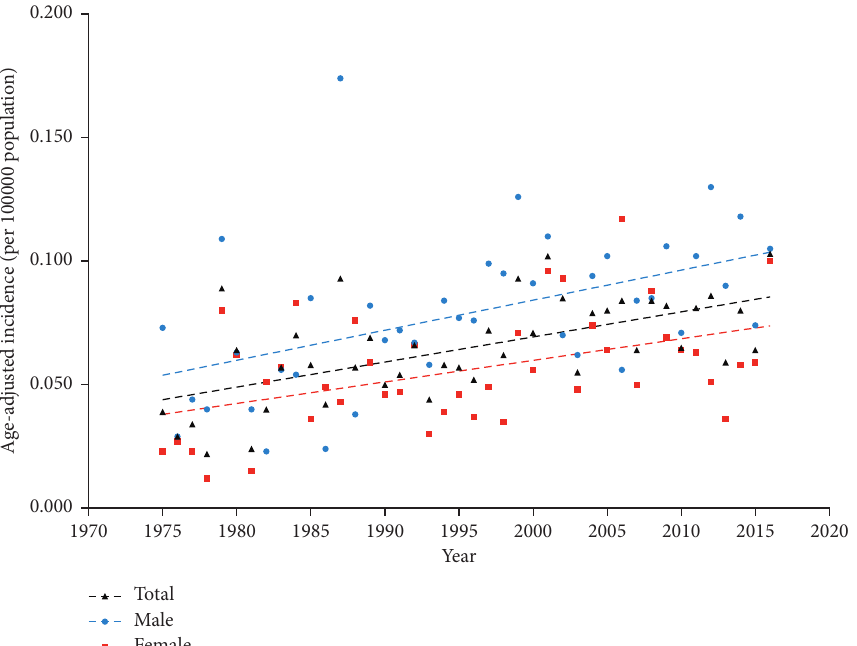
Figure 1: Age-adjusted incidence of eyelid PMM by sex from 1975 to 2016. Linear Regression for trends in age-adjusted incidence (per 100 000 population) of eyelid PMM among males and females. PMM, primary malignant